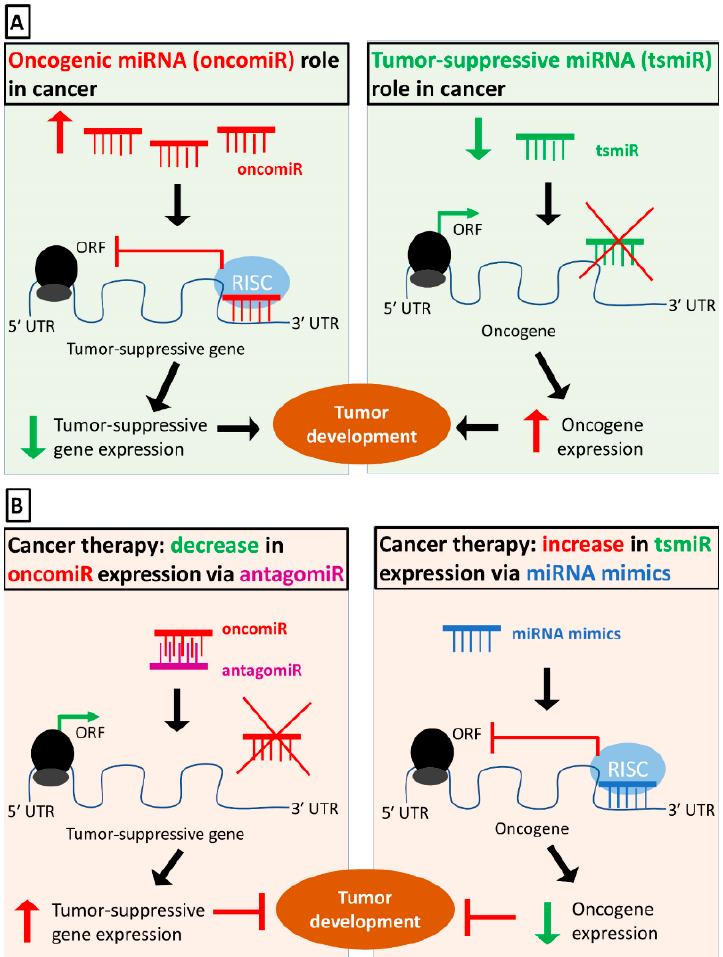
Figure 5. The role of oncogenic and tumor ‐ suppressive miRNAs in cancer, and therapeutic strategies against cancer, based on miRNA targeting. ( A ) The oncogenic miRNAs are highly expressed in cancer; they bind to the 3 ′ UTR of their target genes (tumor suppressors), recruit RISC complex and suppress the expression of their target genes, leading to decreased levels of the respective proteins. In cancer, the tumor ‐ suppressive miRNAs are expressed at low levels. Therefore, they are not able to suppress the expression levels of their target genes (oncogenes), leading to high levels of their proteins. ( B ) For the downregulation of oncogenic miRNAs and the subsequent attenuation of their harmful impact on cellular function, antagomiRs are used. They bind complementarily to the oncogenic miRNA and hence inhibit the binding of the latter to its target. For the upregulation of the tumor ‐ suppressive miRNAs and the subsequent promotion of their beneficial impact on cell function, miRNA mimics are used. They have the same sequence as the specific tumor ‐ suppressive miRNAs and, therefore, are able to bind to the targets of the latter and exert their function. Black arrows indicate the transition to the next step; red lines ( ⊥ ) indicate an inhibitory effect; upstream red arrows indicate an increase in the expression levels, while downstream green arrows indicate a decrease in the expression levels; horizontal green arrows indicate promotion of gene expression.